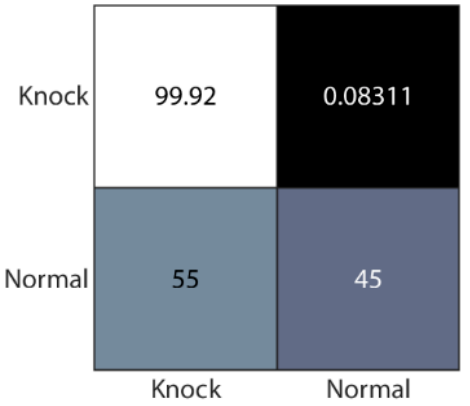
Figure 11. Classification accuracies of the original model with all features.